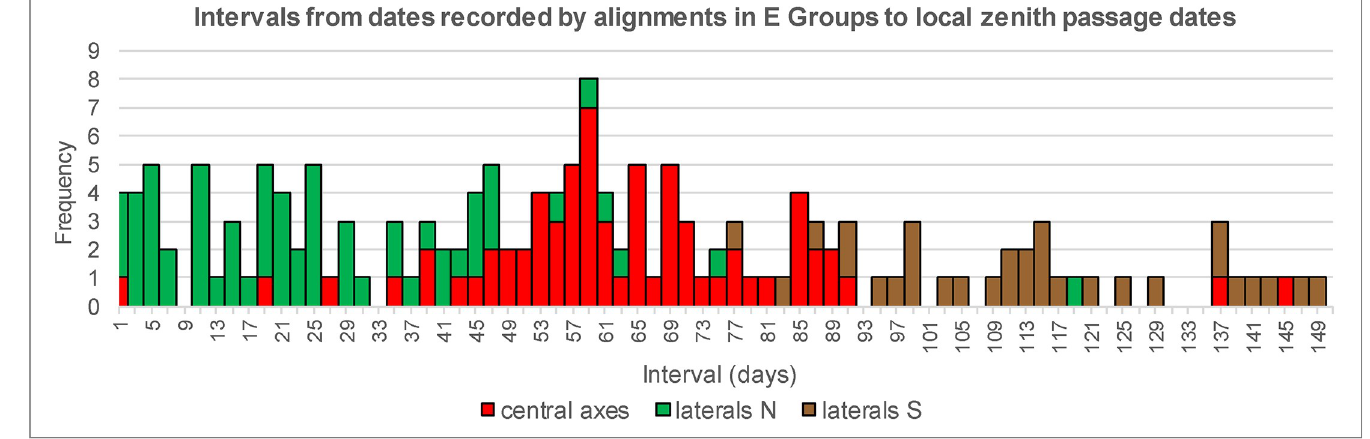
Fig 8. Frequency distribution of intervals from sunrise dates marked by alignments in E Groups to nearest zenith passage dates.